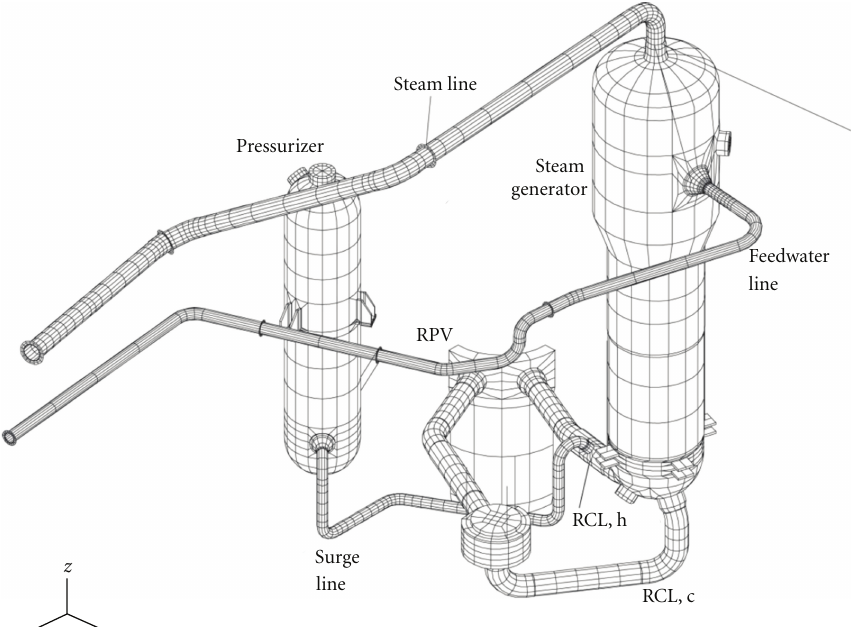
Figure 16: FE model of the coolant loop including surge line and pressurizer.